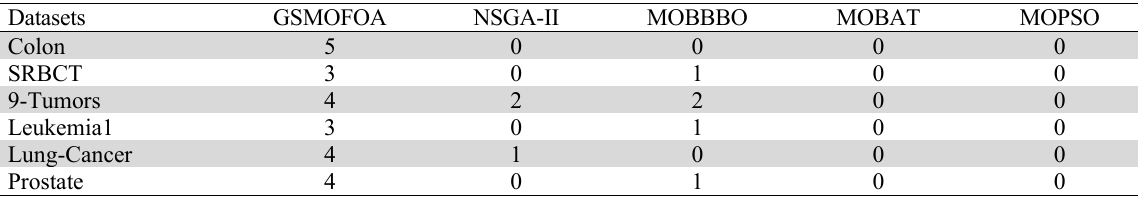
Results of SCC measure on the test